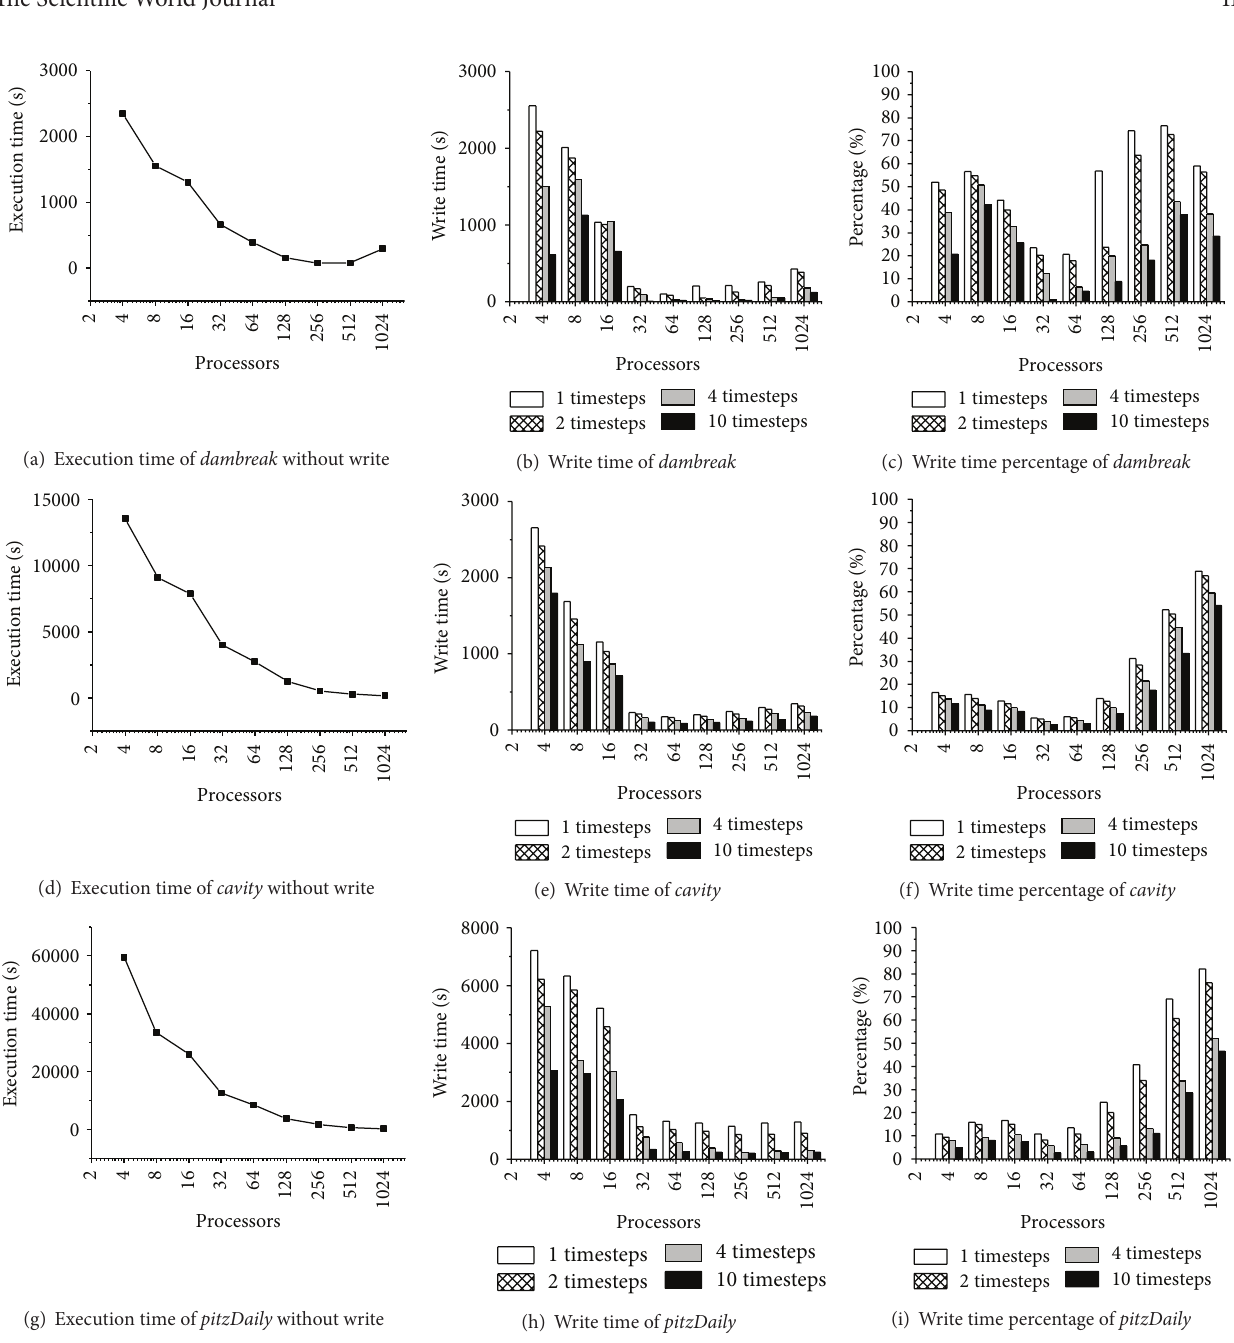
Figure 11: Optimization effect of